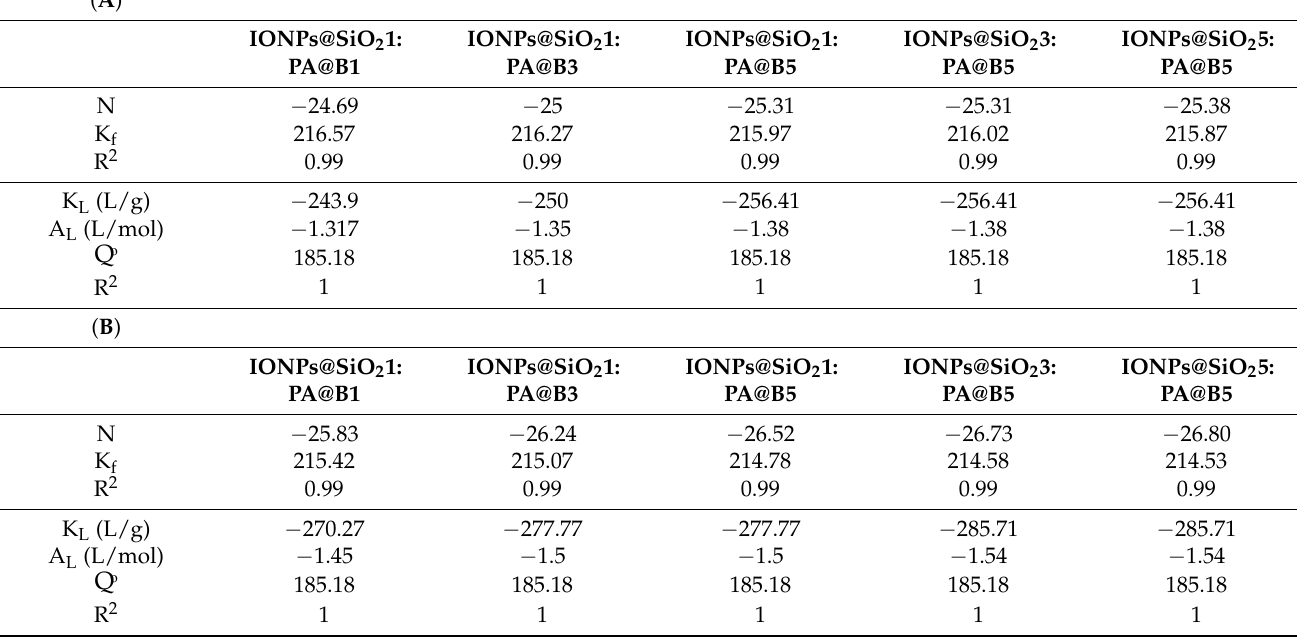
Table 3. (A). Equilibrium isotherms and their values for the loading of aprepitant on